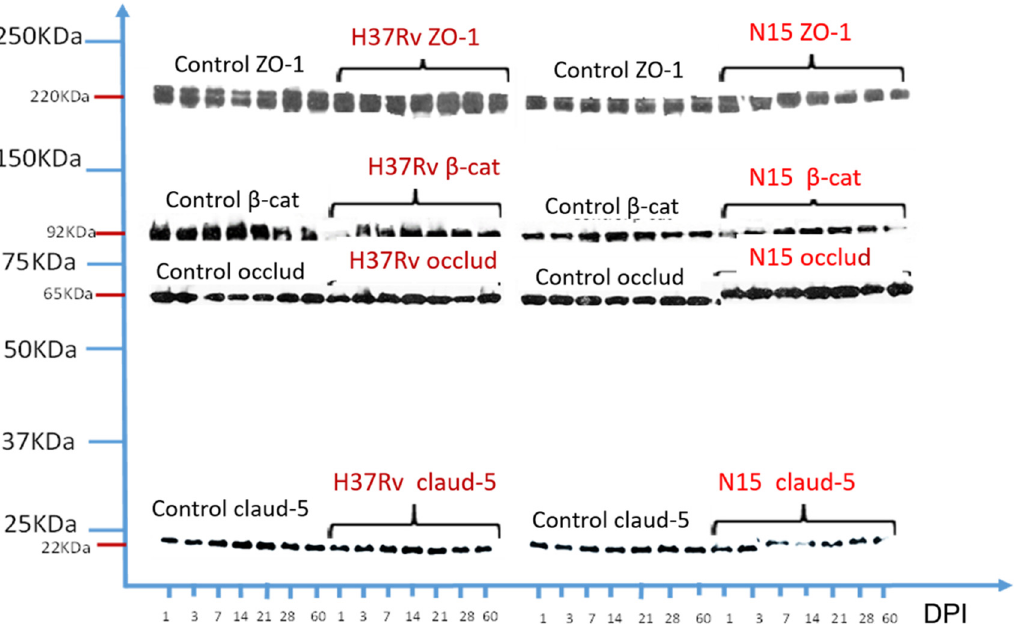
Figure 6. Semiquantitative western blot of changes in cell junction expression in brains of mice infected with M. tuberculosis strains. As we can observe, among the ZO-1 proteins, occludin was phosphorylated during the kinetics of the experiment; claudin-5, in addition to being phosphorylated, shows a decrease in its expression with the M. tuberculosis N15 (LAM3) strain.